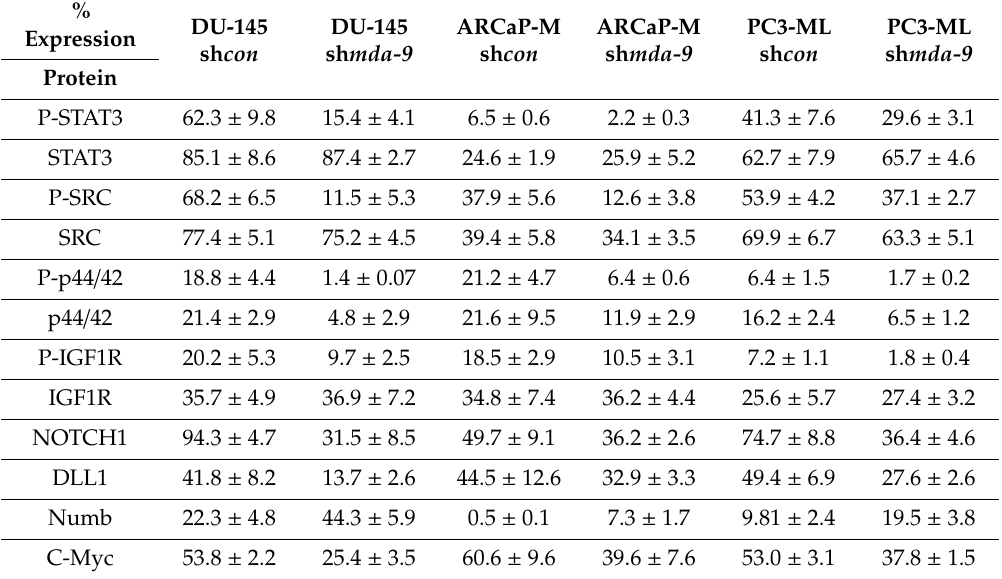
Table 4. E ff ect of mda-9 knockdown (sh mda-9 ) on gene expression in prostate cancer cell lines.